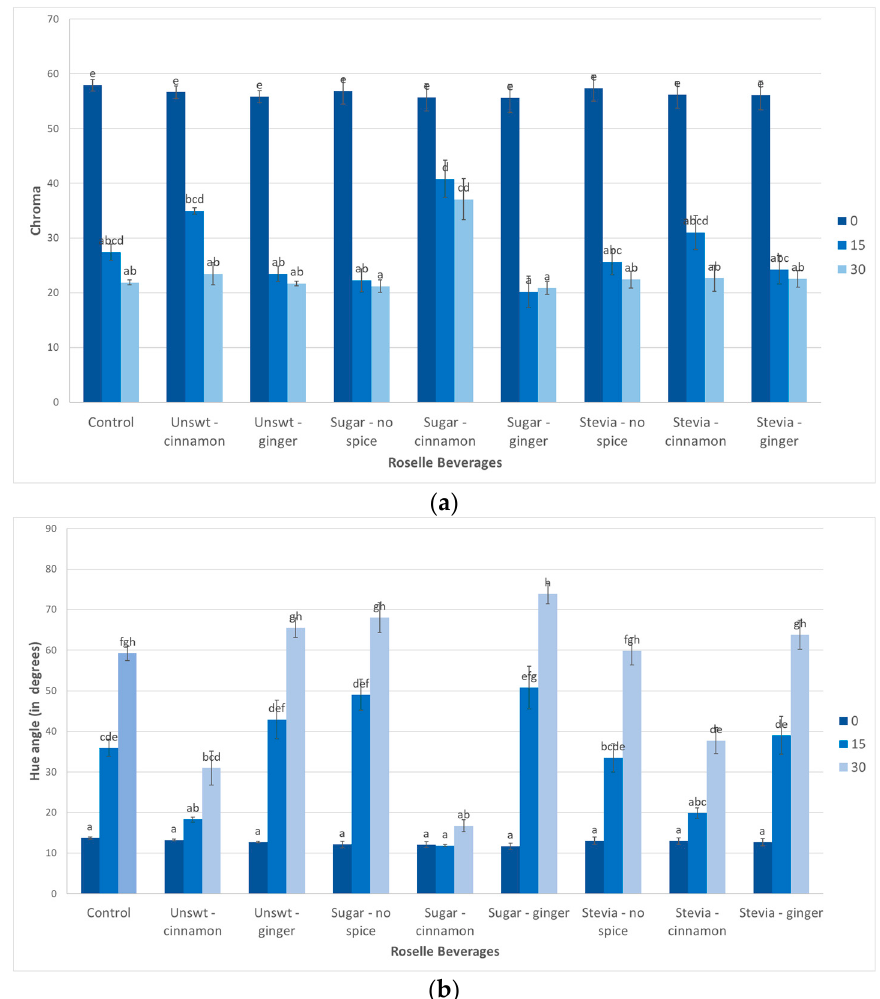
Figure 4. ( a ) Chroma profile of the unsweetened or sweetened Roselle beverages (with sugar or Stevia Reb A) and with or without spice (cinnamon or ginger) on days 0, 15, and 30 of the accelerated ◦ storage at 40 C. ( b ) Hue angle profile of the unsweetened or sweetened Roselle beverages (with sugar or Stevia Reb A) and with or without spice (cinnamon or ginger) on days 0, 15, and 30 of the ◦ accelerated storage at 40 C. Each bar/point represents mean values + SD. Symbols a–h denote the level of differences between